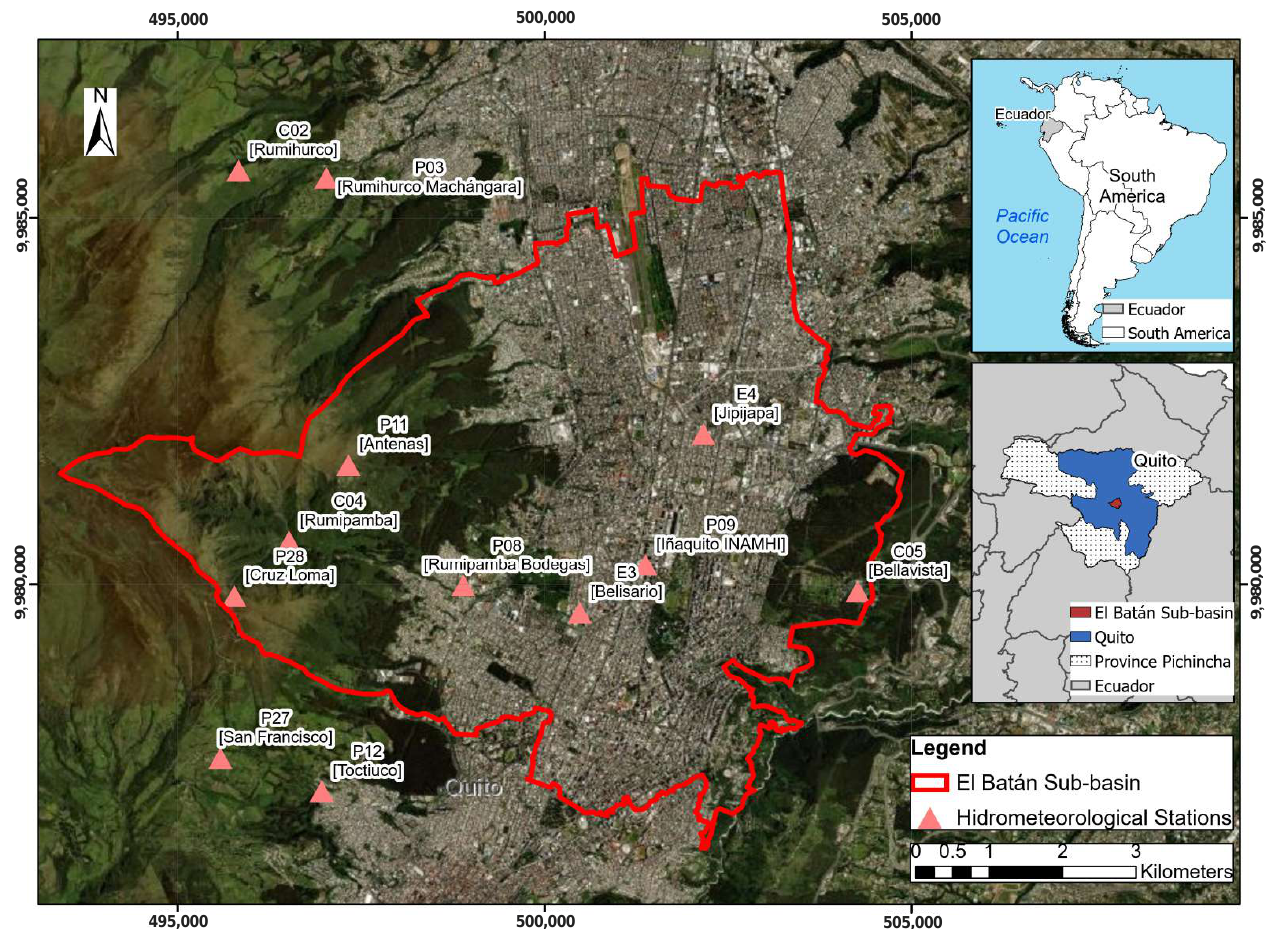
Figure 1. Topographical boundary of the study area: Quito-Ecuador, El Batán sub-basin. The zone is mountainous with an average height of 3049.8 m above sea level (m.a.s.l.), in the high zone it reaches 4555 m.a.s.l. and in the lowest part of the city it oscillates between 2600 m.a.s.l. Furthermore, the temperature ranges between 1.5 and 22 degrees Celsius in the urban area of the basin. This sub-basin has 21.1% mean slope and is characterized by steep slopes. The average annual rainfall in the basin is 1185 mm, while the monthly average ranges between 25 and 175 mm, being April the wettest month with rainfall above 180 mm and August the driest month with just 25 mm. The average humidity of the sub-basin is 80%, with April being the wettest, and August the driest months, which is consistent with the bimodal distribution of rainfall, Figure